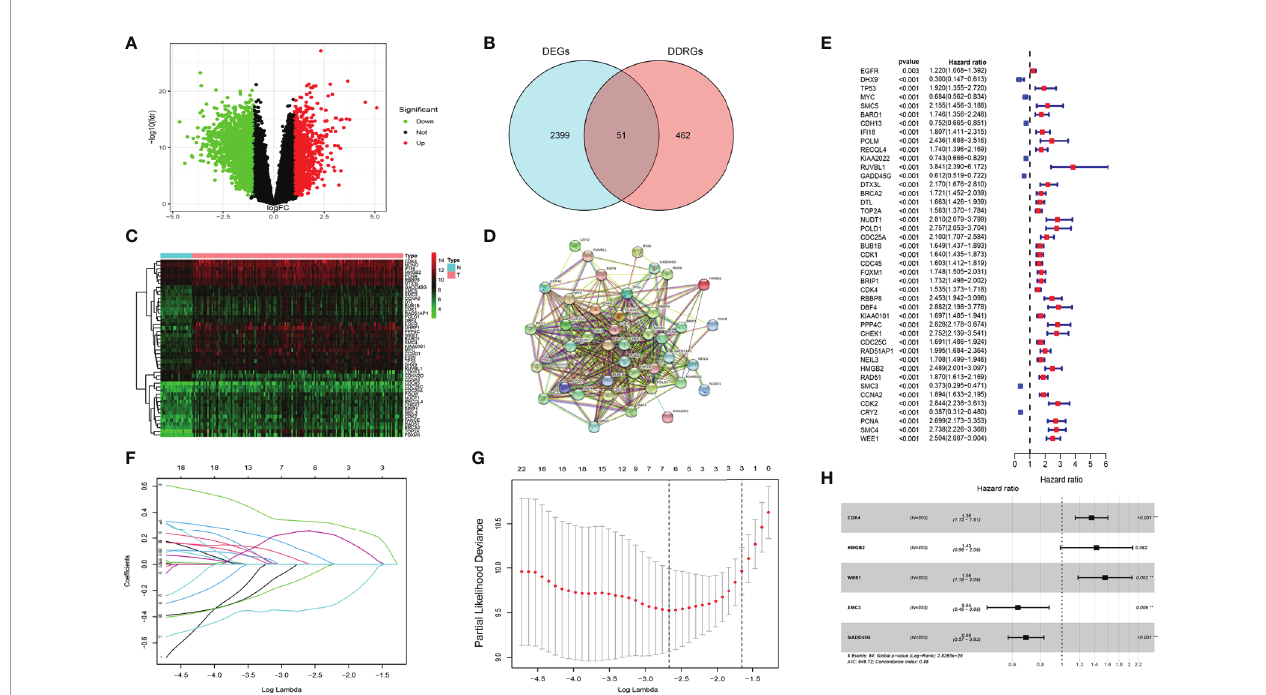
FIGURE 2 | Screening candidate genes and construction a DNA damage repair genes (DDRGs) signature using LASSO regression and Cox proportional hazards regression. (A) Volcano plot of differentially expressed genes (DEGs) between gliomas and normal brain tissues. (B) Venn diagram showing the intersection of DEGs and DDRGs. (C) Heatmap was used to show the expression of the genes at the intersection. (D) The protein – protein interaction (PPI) network downloaded from the STRING database indicated the interactions among the candidate genes. (E) Forest plot showing the hazard ratios from the univariate Cox regression analysis. (F) LASSO coef fi cient pro fi les of the 43 candidate genes in TCGA training dataset. (G) A coef fi cient pro fi le plot was generated against the log (lambda) sequence. Selection of the optimal parameter (lambda) in the LASSO model for TCGA training dataset. (H) Forest plot showing the fi ve genes that composed the DDRGs